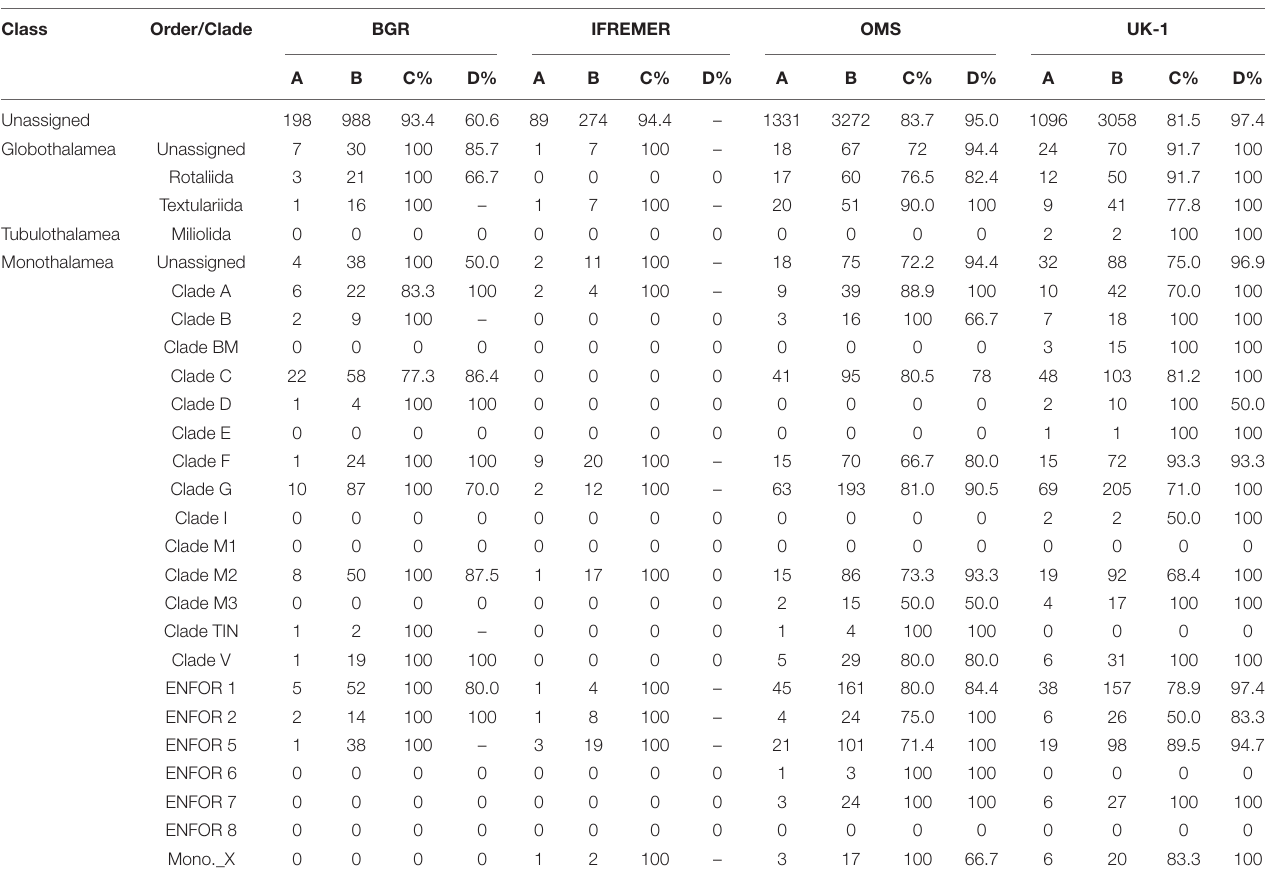
TABLE 4 | Number of OTUs that are confined to one CCZ area, station or single core. Data are arranged according to foraminiferal orders or clades and include only OTUs that are confined to the CCZ. A = number of OTUs found only in this area; B = total number of OTUs in the full dataset; C = percent of ‘A’ found at only one station; D = percent of ‘A’ found in only one core from this station. Note that a dash in column D indicates that only one core was sampled for metabarcoding. Two cores per station were always sampled in the OMS and UK-1 areas, but only one core was sampled per station in the IFREMER area and at some of the BGR